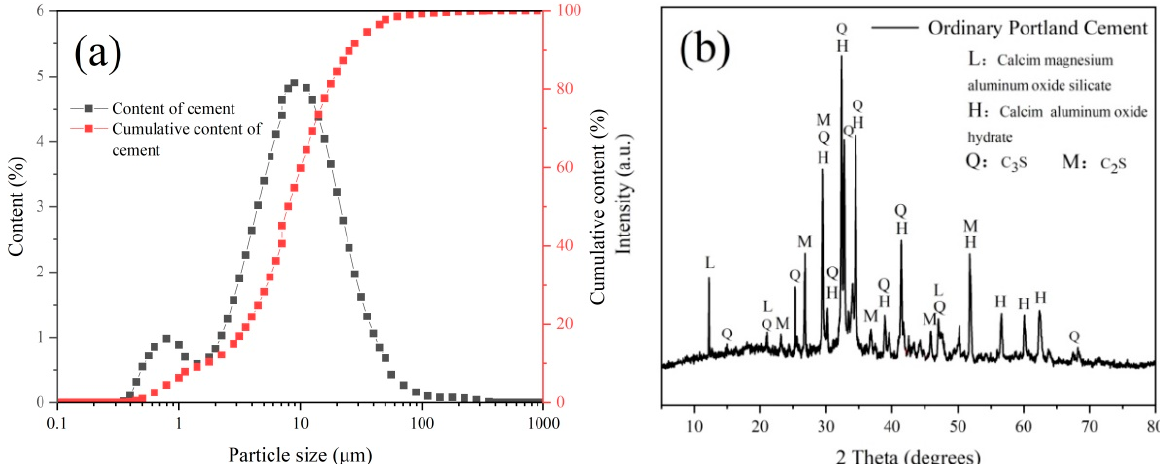
Figure 11. ( a ) Particle size distribution and ( b ) XRD pattern of cement.